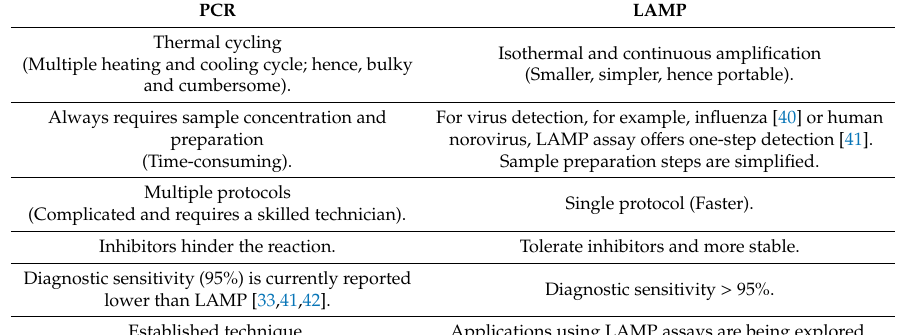
Table 2. Comparison between PCR and loop-mediated isothermal amplification (LAMP) reactions